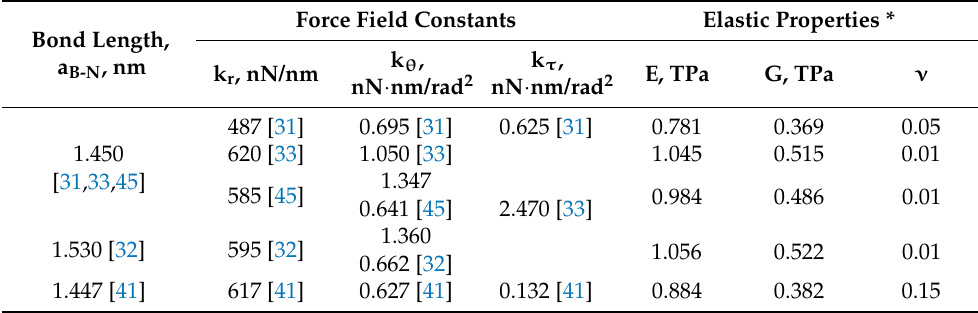
Table 7. Young’s and shear moduli and Poisson’ ratio of SWBNNTs evaluated in the present numerical simulation study using different sets of the input parameters.